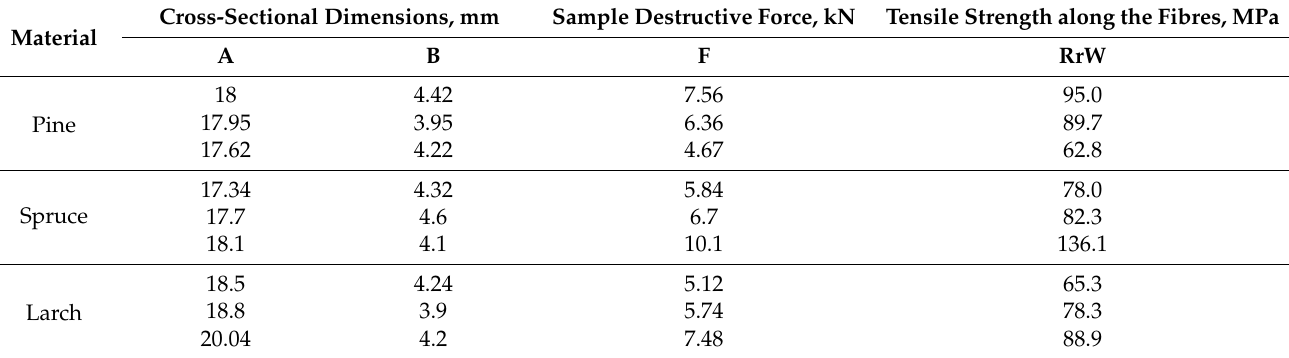
Table 1. Tensile testing along the fibres of respective materials for native material.